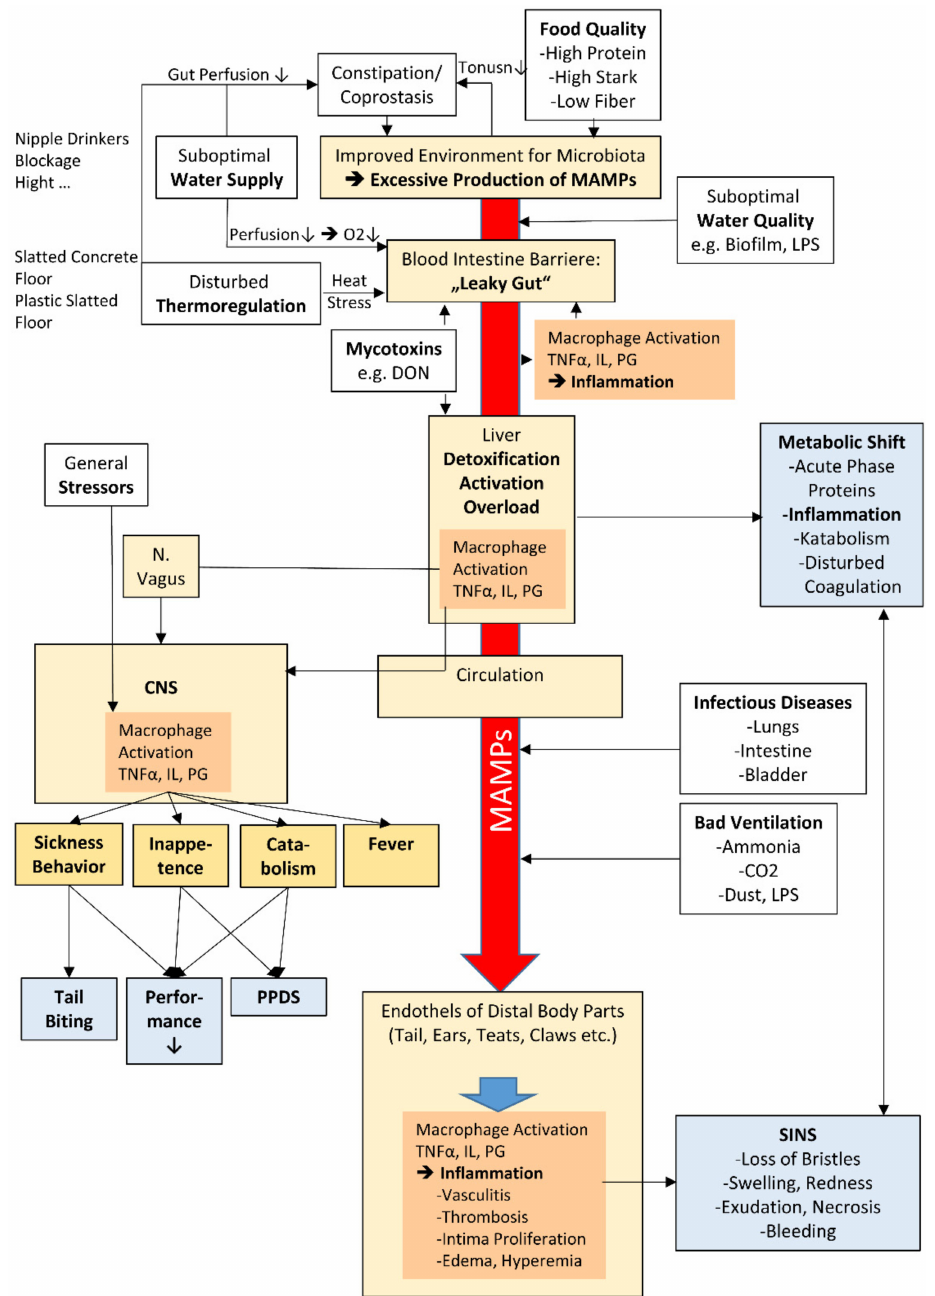
Figure 2. Hypothesis of the mechanisms leading to inflammation and necrosis syndrome (SINS). The focus is on microbe- associated molecular patterns (MAMPs, red arrow). Suboptimal water supply, thermoregulation, and food and water